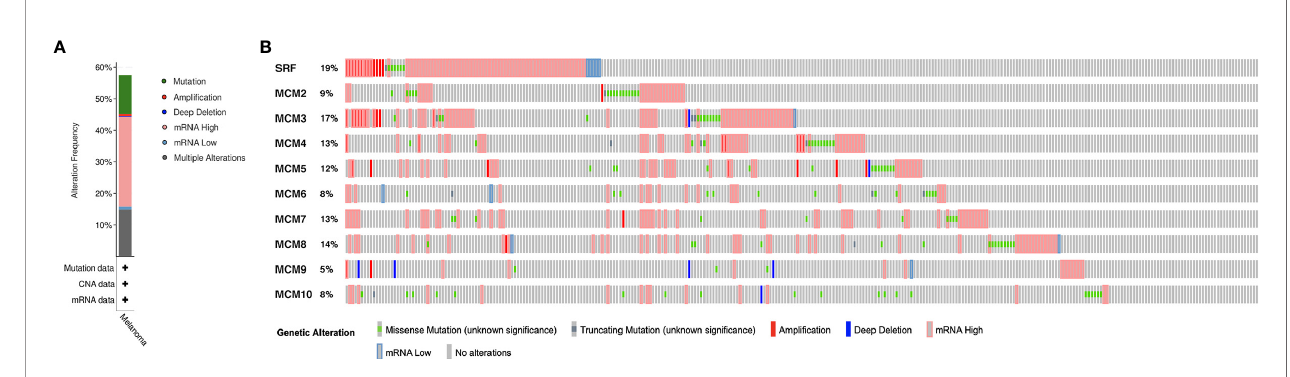
FIGURE 8 | Genetic mutations in MCM family members (cBioPortal). (A) A visual summary of alteration based on a query of 10 MCM s, which was altered in 255 samples out of 444 SKCM patients (57.43%). (B) MCM1 (SRF) (19%) was the most frequently altered gene among the MCM genes, followed by MCM3 (17%),